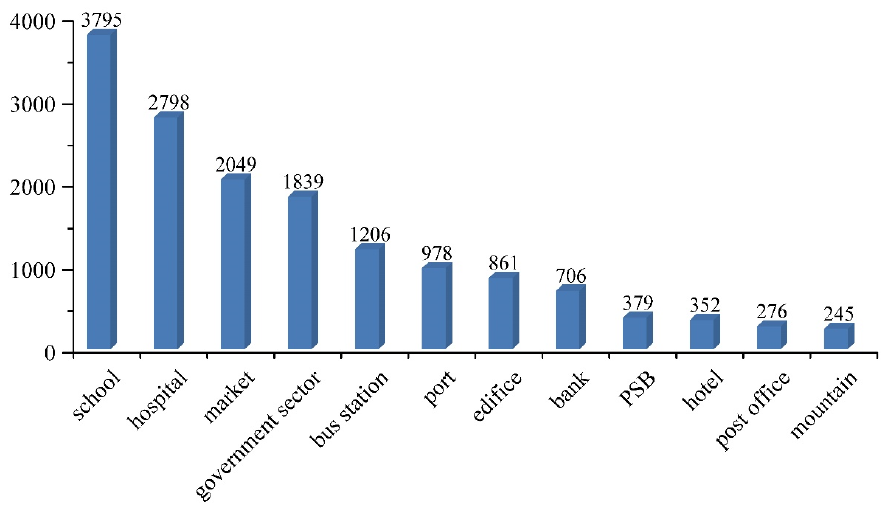
Figure 4. Point symbols dataset labeling plot.